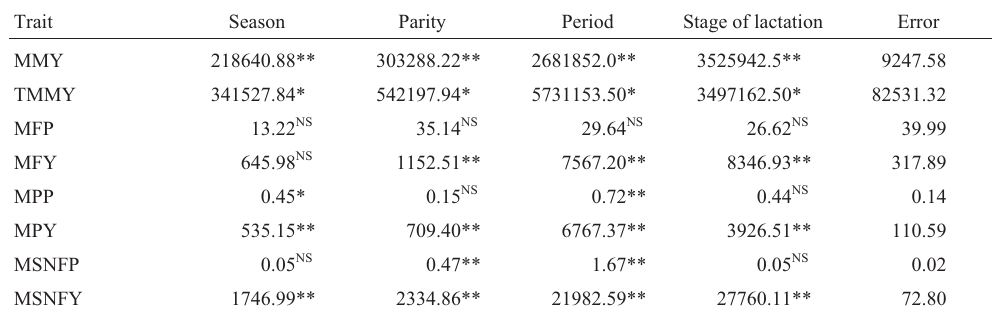
Table 1 - Least-squares variance analysis (mean squares) of lactation traits of Sahiwal cattle .